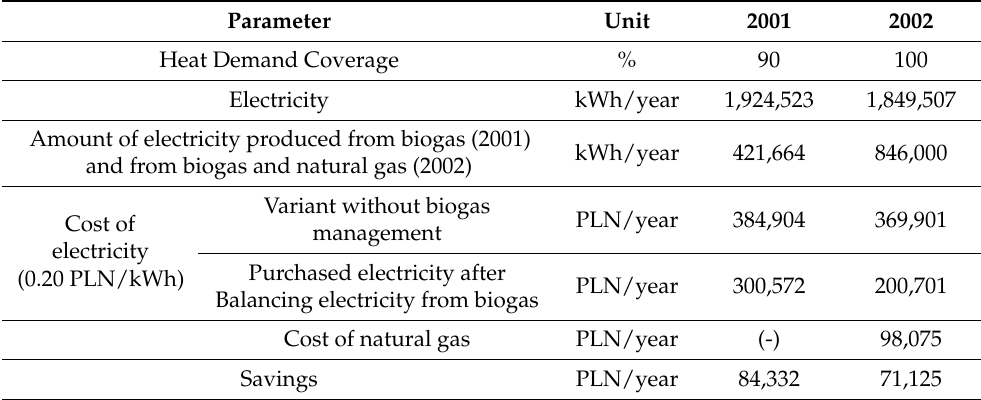
Table 2. Comparison of the energy balance of the Gubin–Guben WWTP, 2001 and 2002. Parameter Unit